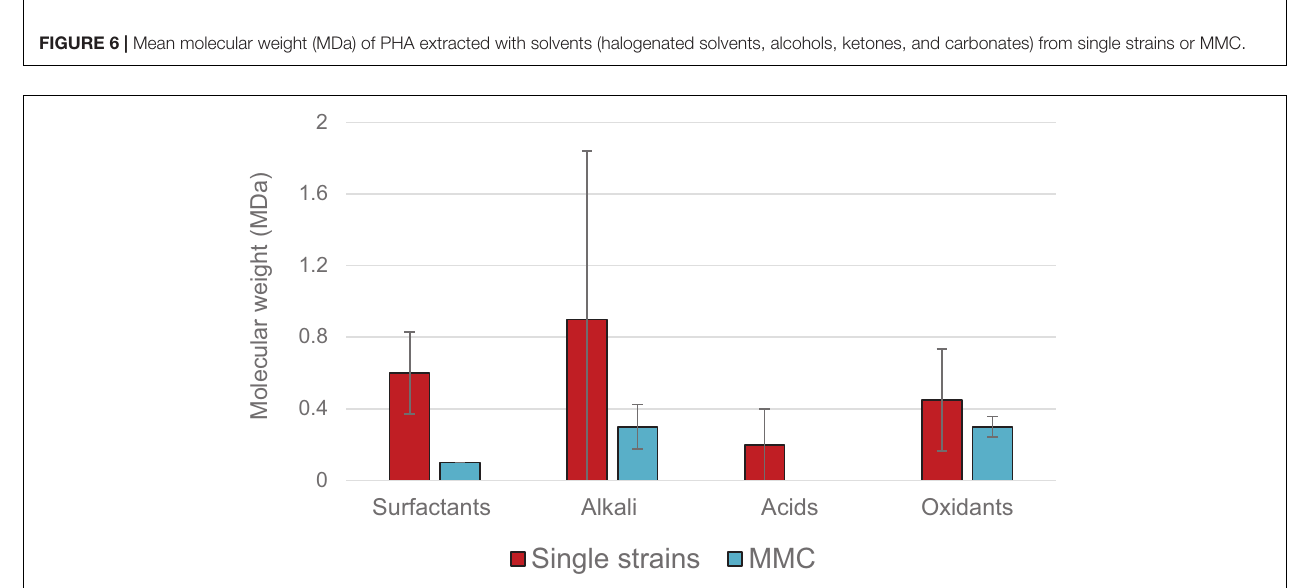
FIGURE 7 | Mean molecular weight (MDa) of PHA extracted through cellular lysis (with surfactants, alkali, acids, and oxidants) from single strains or